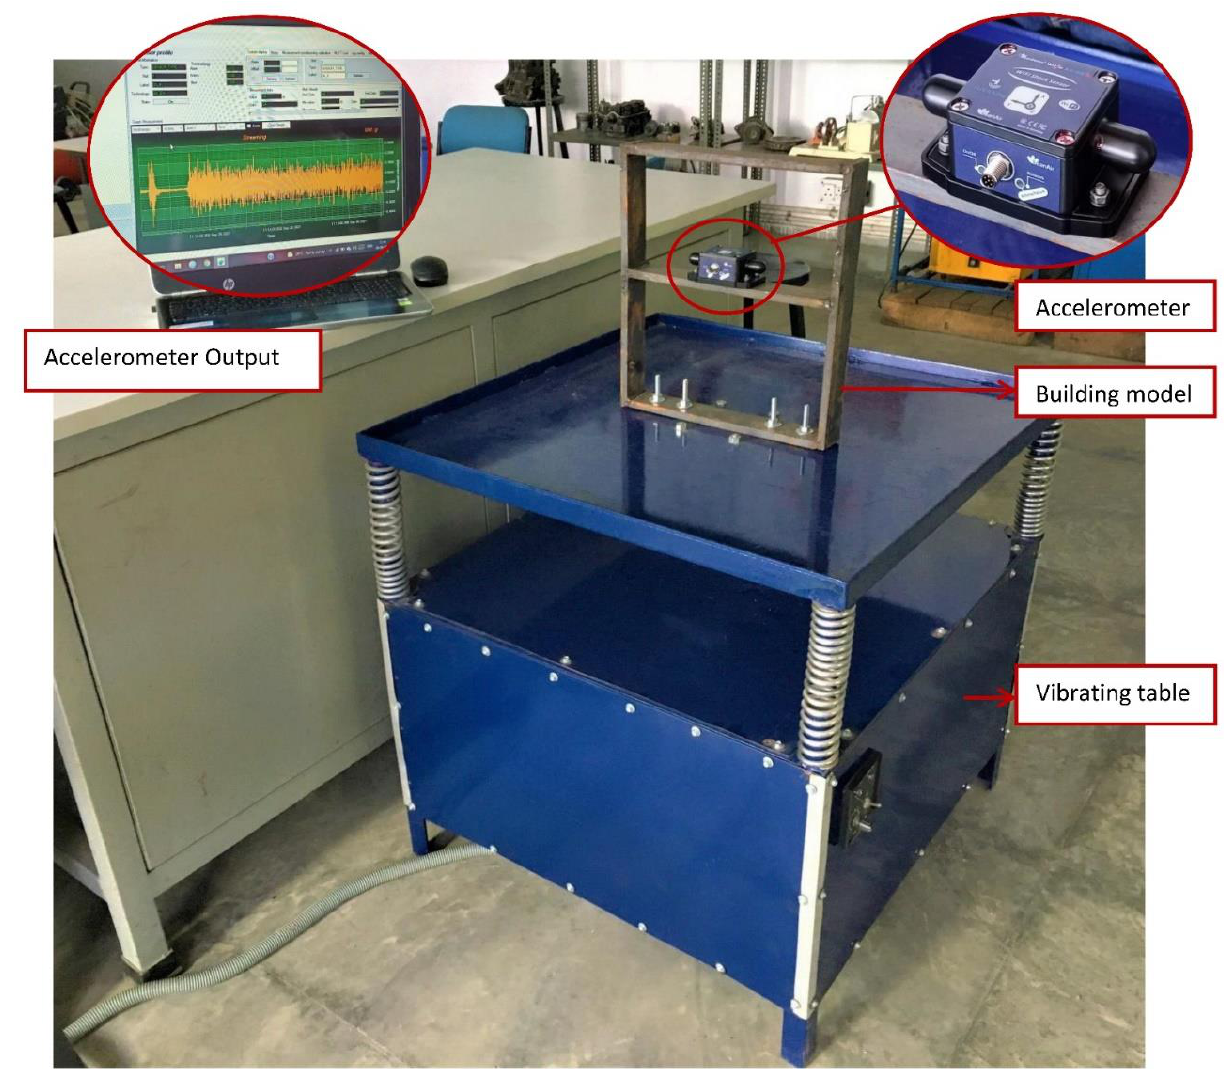
Figure 2. Experimental Setup.